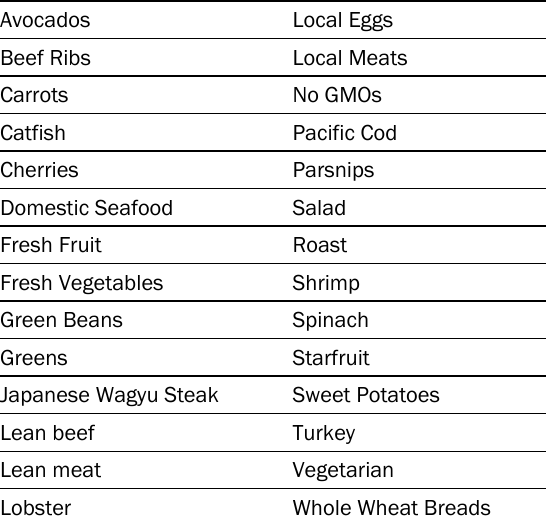
Table 3. Foods Wanted in Diet, n